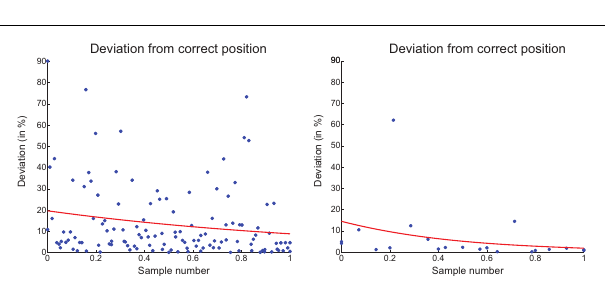
FIGURE 7 | Number of played samples per skill for Anne (A) and Jane (B).